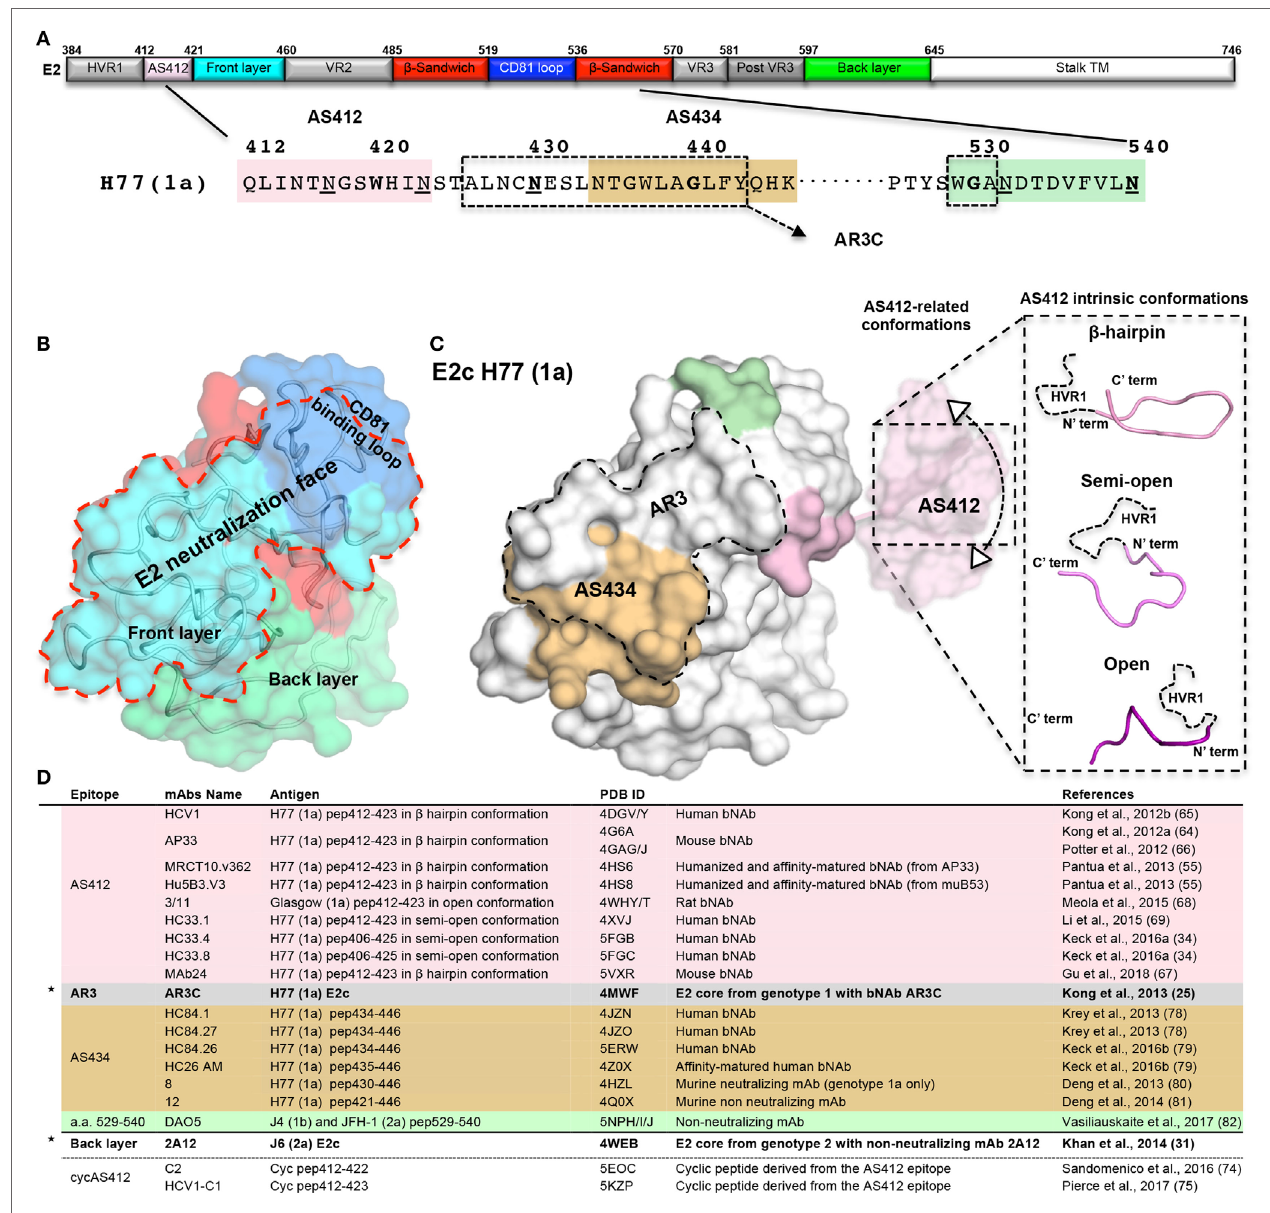
FiGURe 1 | The neutralizing face of the hepatitis C virus E2 glycoprotein. (A) Schematic representations of E2 regions (a.a. 384–746, based on the prototypic isolate H77 numbering system) colored by structural components with variable regions in gray, AS412 region in pink, front layer (FL) in cyan, β -sandwich in red, CD81 binding loop (CD81bl) in blue, back layer (BL) in green, and the stalk and transmembrane region (TM) in white. The a.a. sequence of the neutralization face (a.a. 412–446 and 525–535) and the epitope of mAb DAO5 is shown below. The AS412, antigenic region 3, and AS434 neutralization epitopes are marked in pink, dashed rectangle, and wheat. The epitope of the non-neutralizing mAb DAO5 is marked in green. The N-linked glycosylation sites surrounding the neutralizing face (N417, N423, N430, N532, and N540) are underlined. (B) Surface representation of the E2c structure (25) (PDB entry 4MWF) with the structural components colored as in (A) . The neutralizing face is marked by a red dashed line. (C) The E2 neutralizing epitopes on the E2c structure. For the AS412 epitopes, a.a. 412–420 are modeled onto E2c based on the AP33 bNAb-AS412 crystal structure (PDB entry 4G6A). The conformational flexibility of AS412 related to the E2 (30) is schematically shown. The three known AS412 conformations ( β -hairpin, semi-open, and open) for neutralization are shown on the right. (D) Summary of the E2 crystal structures. The two E2 core domain-mAb structures are marked by